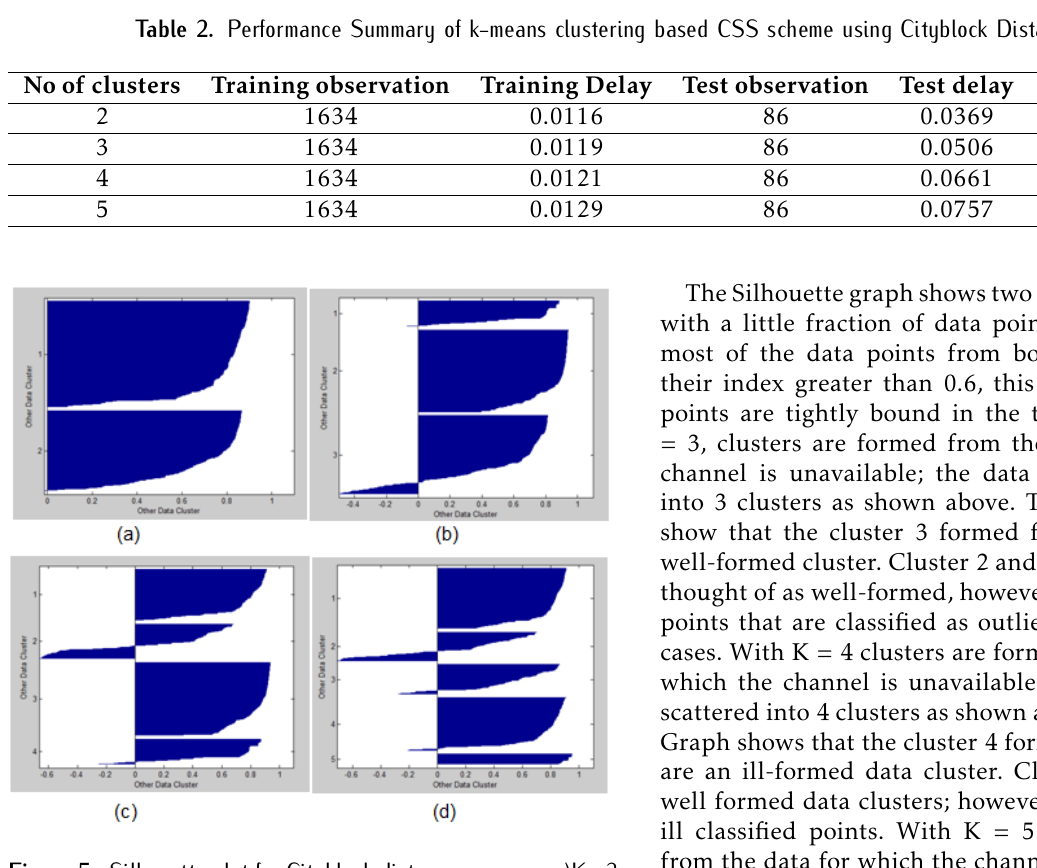
Figure 5. Silhouette plot for Cityblock distance measure: a)K=2 b)K=3 c)K=4